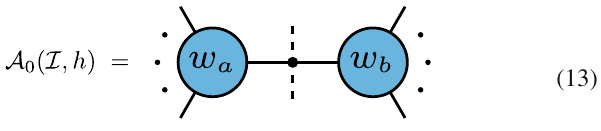
be repeated for all independent helicity configuration h a